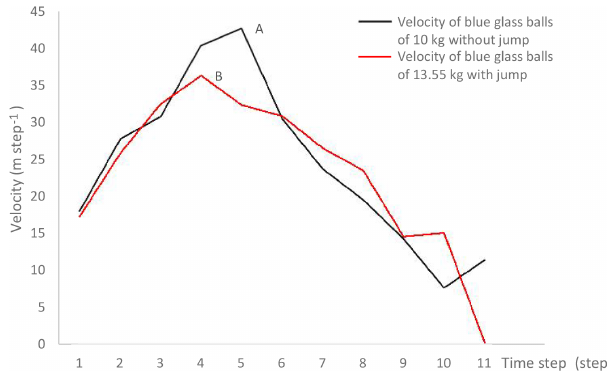
Figure 12. Maximum velocity of blue glass balls in the numerical